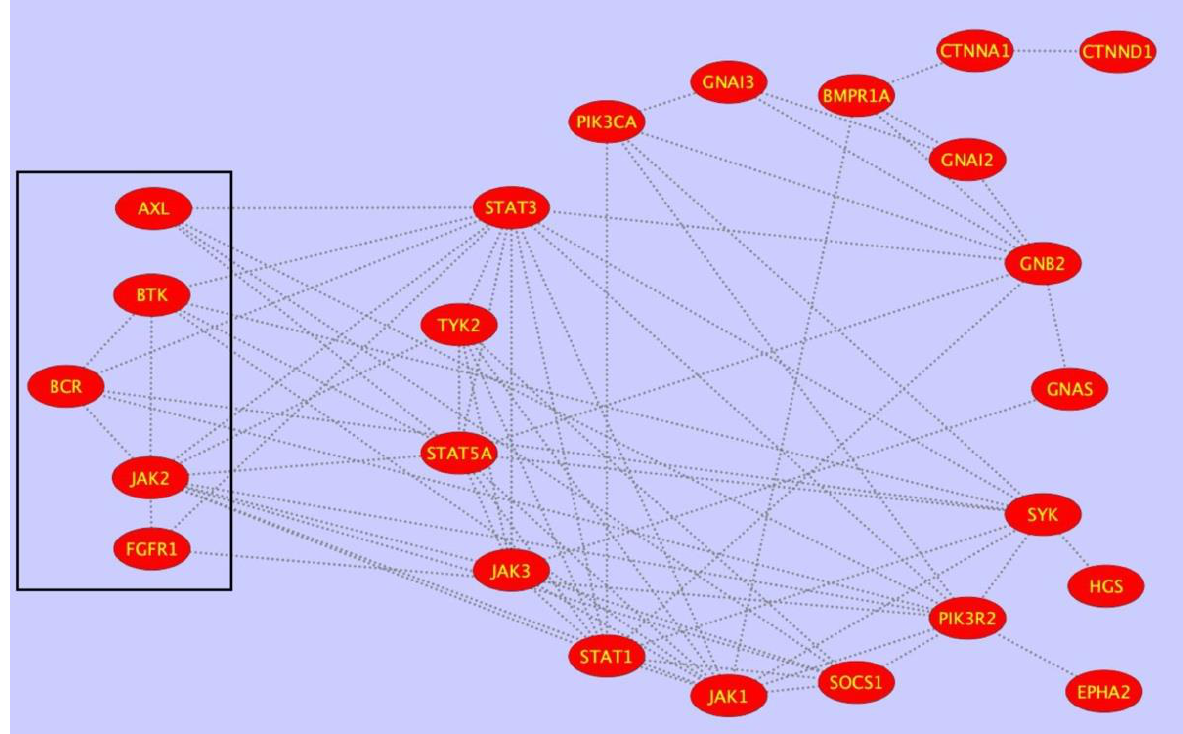
Figure 4. Sub-network of 24 nodes and 72 interactions extracted by applying mathematical filters to the PTPRG-specific first neighbor (FN) PPI network of 2976 nodes (interactors) connected by 123,961 binary, non-redundant, un-directed edges. The sub-network was generated by using OR and AND Boolean operators and allowed extracting the most topologically relevant nodes, all characterized by values of betweenness, centroid, degree, and bridging centralities over the average. This sub- network possibly represents a highly relevant regulatory signaling module in PTPRG physiology. Table 2. Ontology and statistical analyses were applied to identify the most represented signaling pathways and pathological processes regulated by the sub-network described in Figure 1. Analyses were done in the context of KEGG, Reactome, and GO databases and show the node participation to individual pathways. Functional relevance is proportional to the XD-score and q-values.